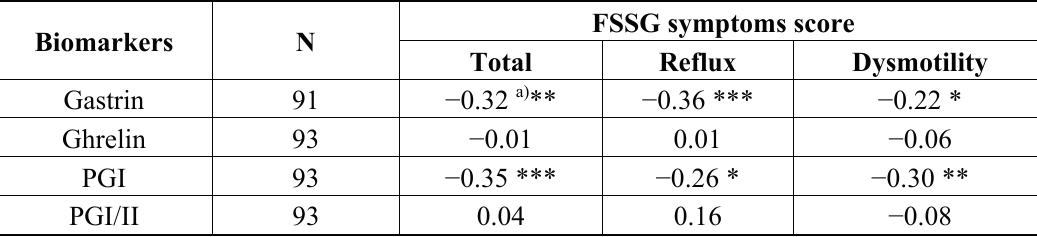
Table 4. Correlation between the stomach-related biomarkers and the FSSG scores.